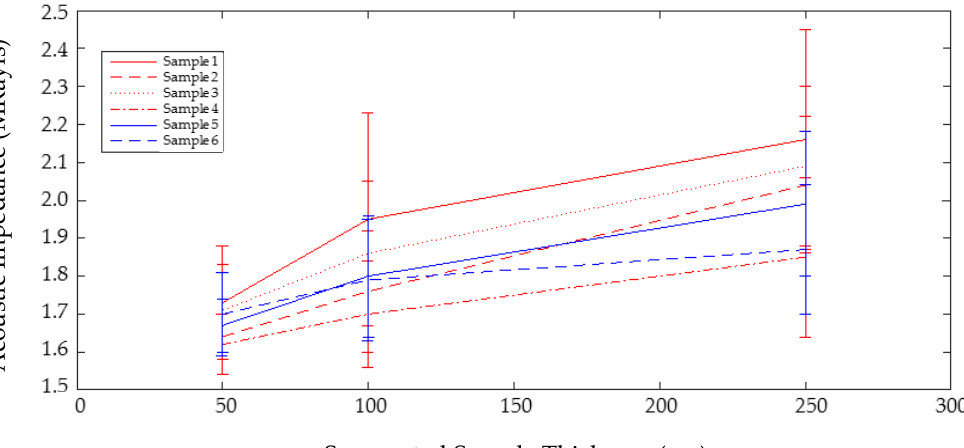
Figure 4. Increase in acoustic impedance as a function of segmented tissue thickness. Error bars show standard deviation across the full 30 mm scan for each sample.